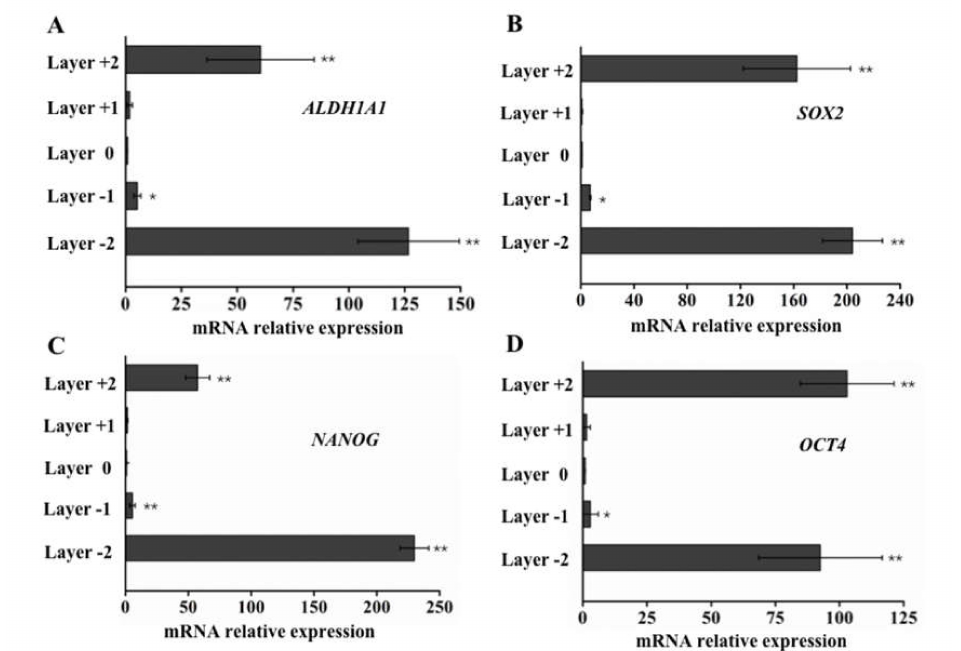
Figure 5. Relative expression of putative CSC-specific markers measured by real-time quantitative PCR analysis. Real-time PCR-quantified levels of expression of ALDH1A1, NANOG, OCT4, and SOX2 transcripts using 2- ∆∆ Ct values relative to glyceraldehyde-3-phosphate dehydrogenase (GAPDH) as an internal control. Error bars represent the standard deviation for 24 replicate zones, * denotes p < 0.05, ** denotes p <